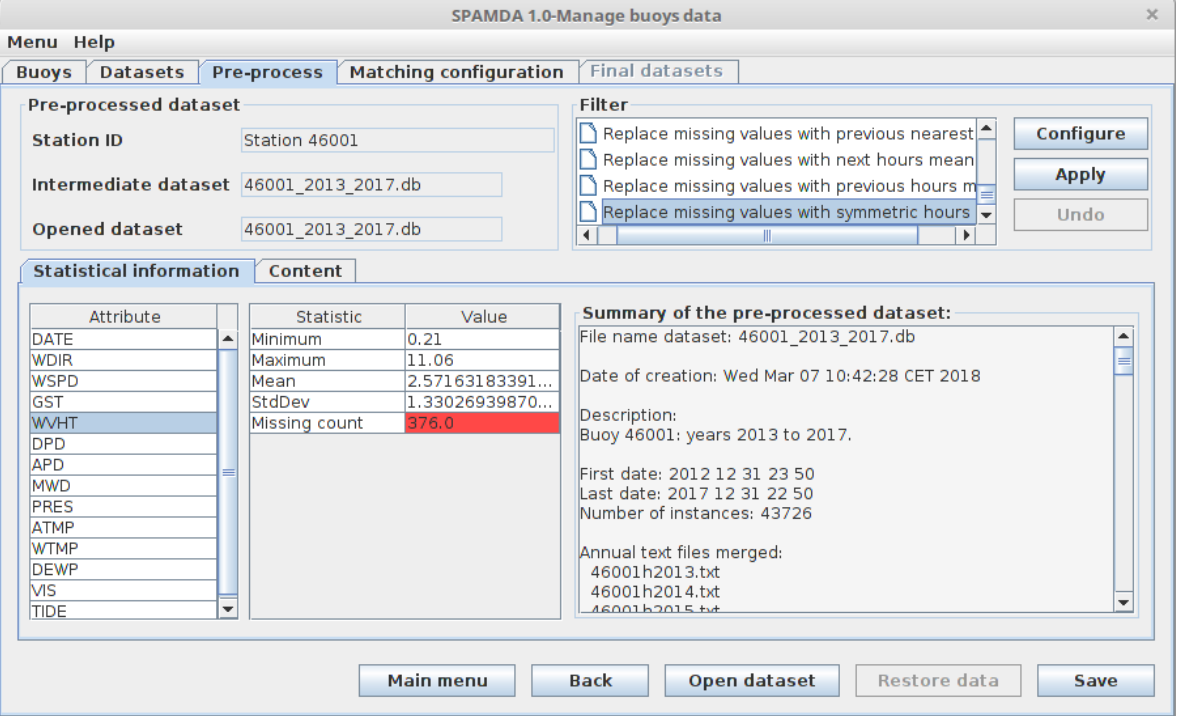
Figure 18. Pre-process tab: pre-processing the created intermediate